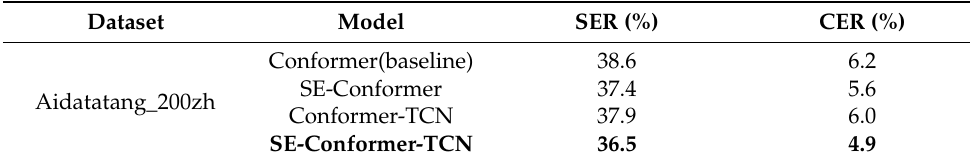
Table 7. Performance of Conformer with different